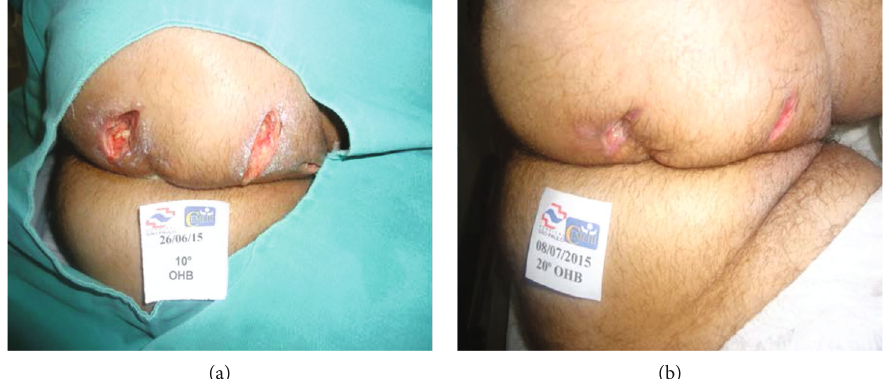
Figure 2: Signi fi cant healing of perineal fi stulizing Crohn ’ s disease wounds observed at the beginning of treatment (10 sessions) after perineal surgery (a) and at the end of 20 sessions (b).